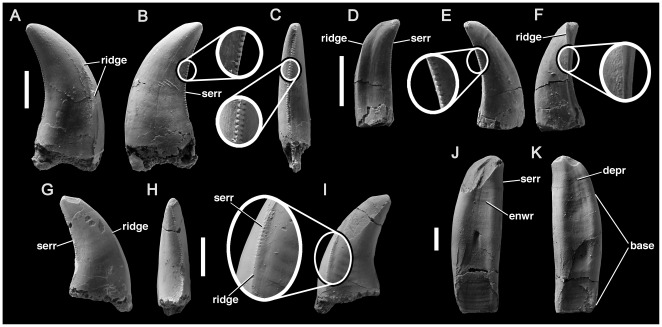
Theropod teeth from the Flat Rocks Site preliminarily referred to Megaraptora.NMV P186353 (A–C), P210084 (D–F), P212859 (G–I), and P230871 (J–K) in labial (A, G), lingual (B, D, I), distal (C, F, H), mesial (E) and undetermined (J–K) views. Scale bars equal 5 mm.